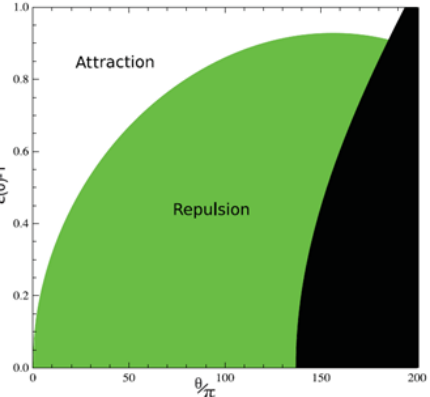
Figure 1. Attraction and repulsion at T → ∞ and θ 1 = − θ 2 = θ . The forbidden region is given in black. (Figure is taken from reference [18]).